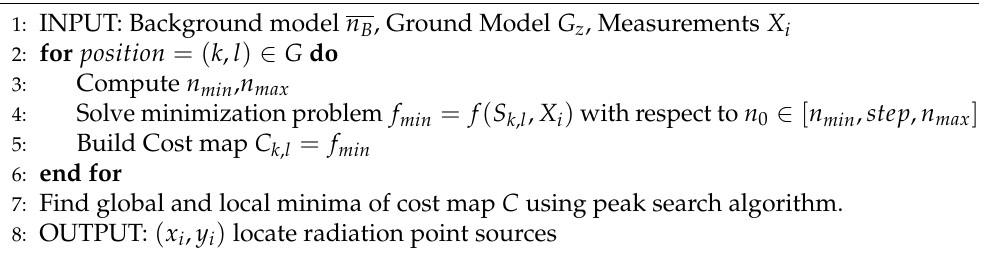
Algorithm 1 Radiological source localization algorithm